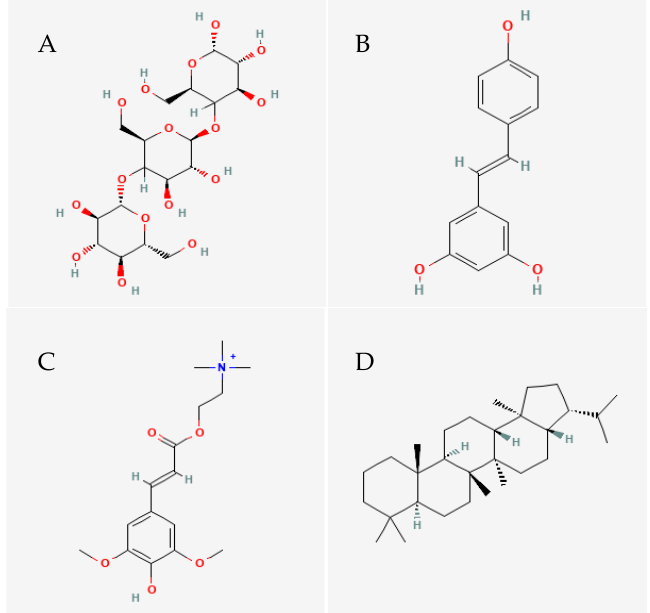
Figure 1. Chemical structure depiction of four representative functional plant extracts: ( A ) β-glucan; ( B ) resveratrol; ( C ) sinapine; ( D ) hopanes (reproduced with permission from [63]).